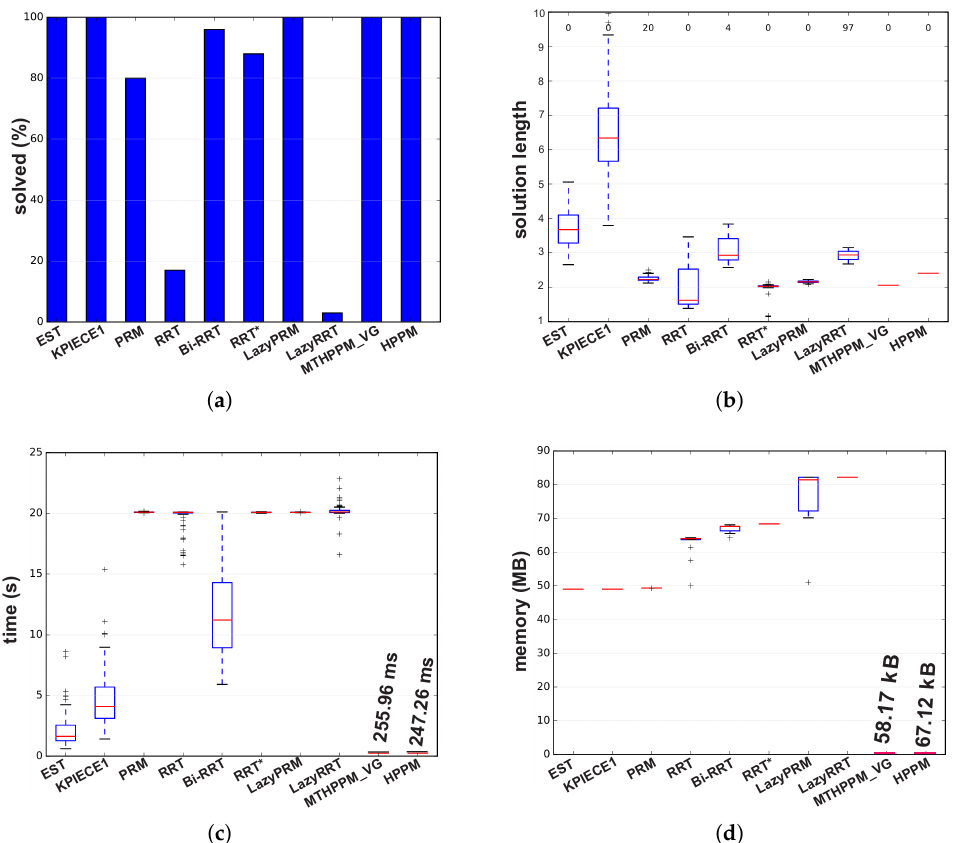
Figure 24. Comparative results for case study 4. ( a ) Successful paths. ( b ) Path length. ( c ) Execution time. ( d )